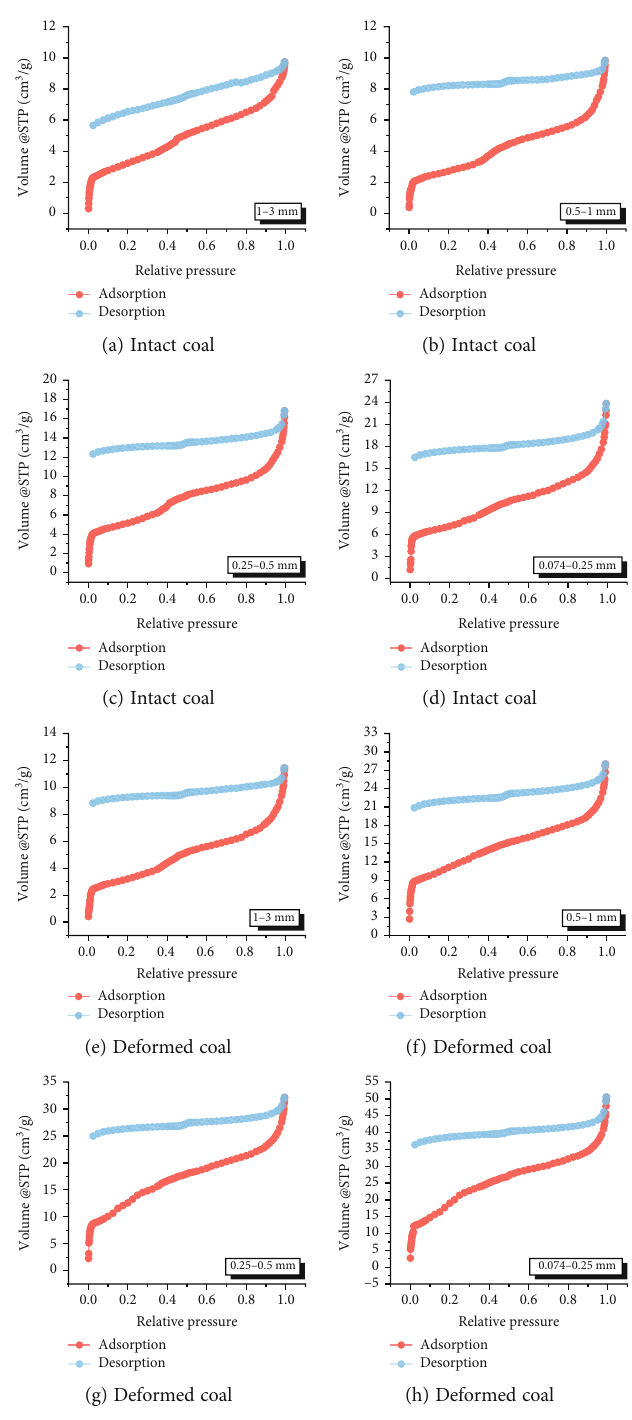
Figure 4: Liquid N